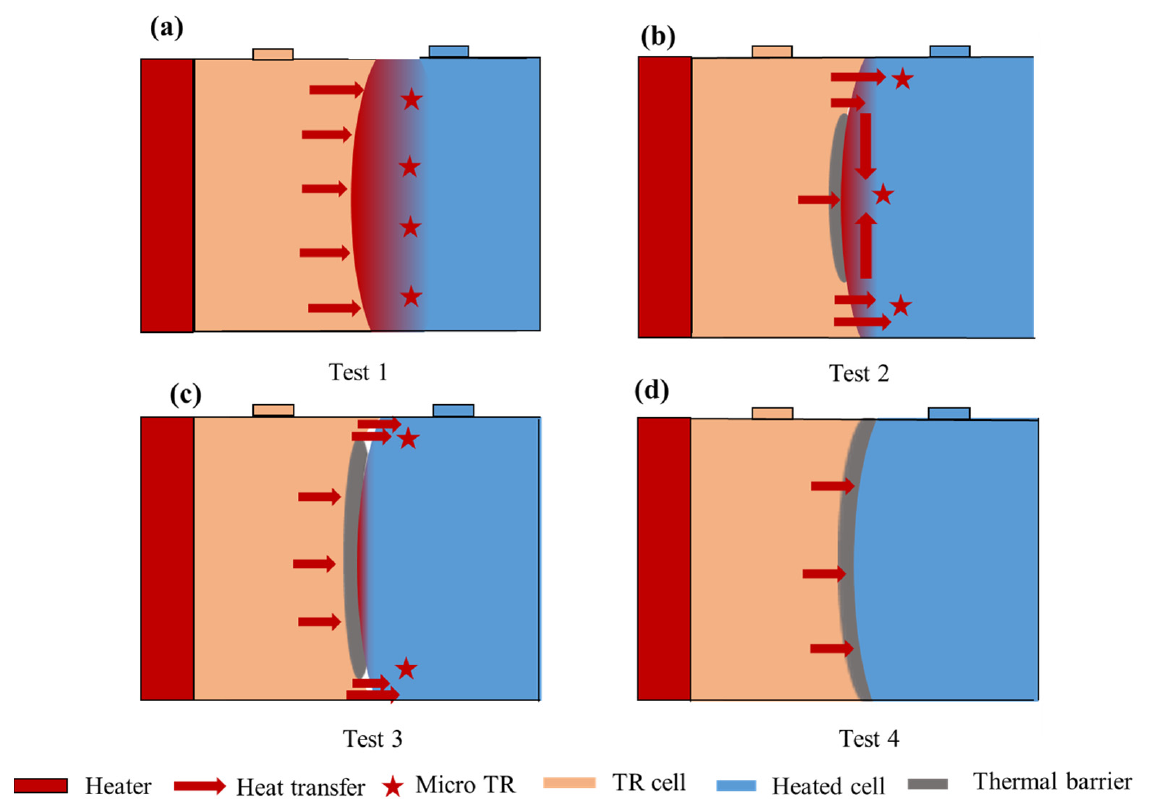
Figure 8. Heat transfer path: ( a ) test 1; ( b ) test 2; ( c ) test 3; and ( d ) test 4.